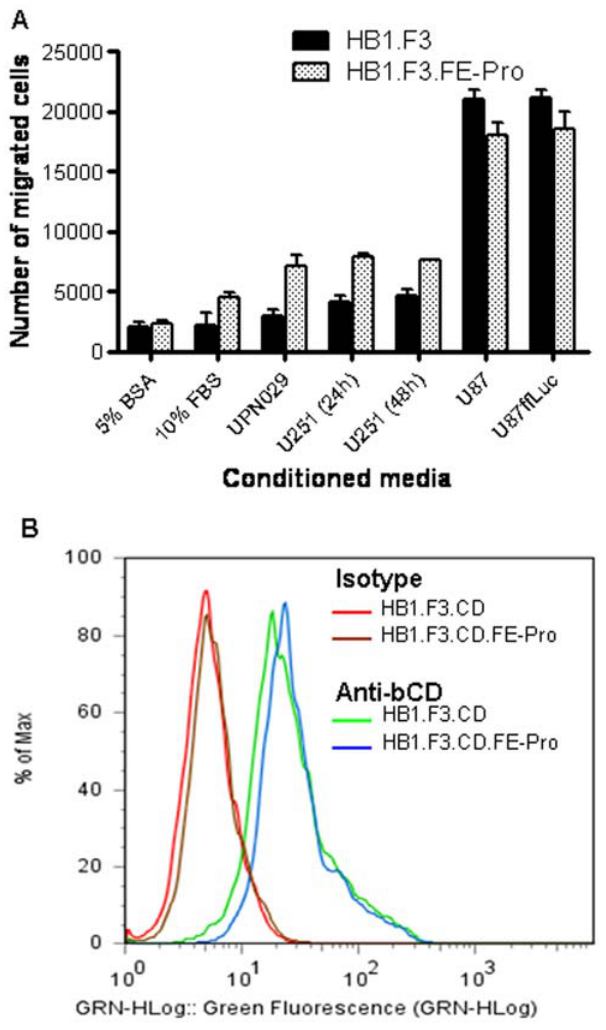
Figure 3. Functionality of FE-Pro labeled NSCs. (A) Results from Boyden chamber migration assays, showing inherent NSC migration towards conditioned media from U251 (media collected at 24 and 48 hours), UPN029, U87, and U87ffluc cell lines. P , 0.05 was considered statistically significant. (B) Flow cytometry plot, showing expression of Cytosine Deaminase (CD) in non-labeled (red (isotype control) and green (anti-bCD)) and FE-Pro-labeled (brown (isotype control) and blue (anti-b-CD)) HB1.F3.CD cells. Abbreviations: HB1.F3.CD.FE-Pro, FE-Pro- labeled HB1.F3.CD NSCs; Anti-bCD, anti-bacterial CD primary antibody.